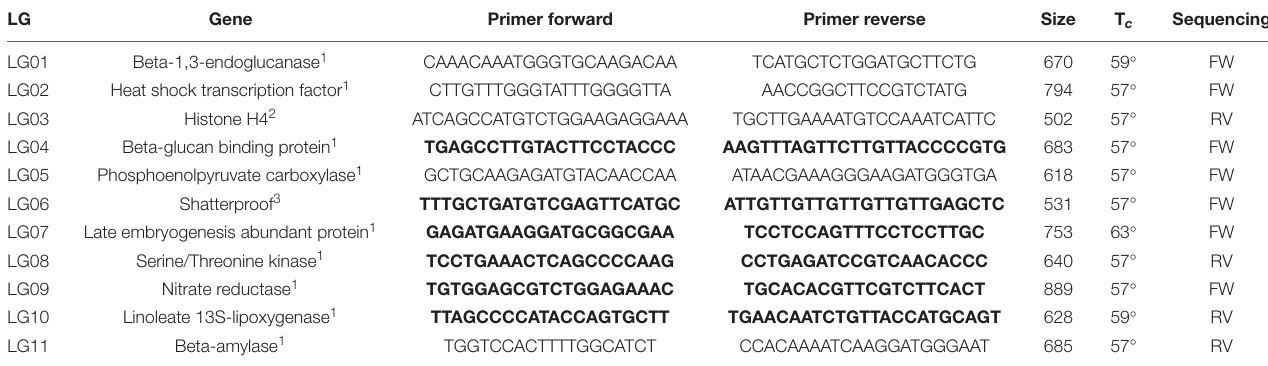
TABLE 3 | List and basic information on the Mendelian loci (expressed regions) selected for DNA haplotyping, including genomic localization (linkage group, LG), gene name, sequences of primer pairs used for PCR amplification, size of the amplified fragment (bp), temperature of annealing (Ta ◦ C), and primer used for sequencing (highlighted in bold) in order to obtain amplicons < 900 bp in length in substitution to the original ones. LG